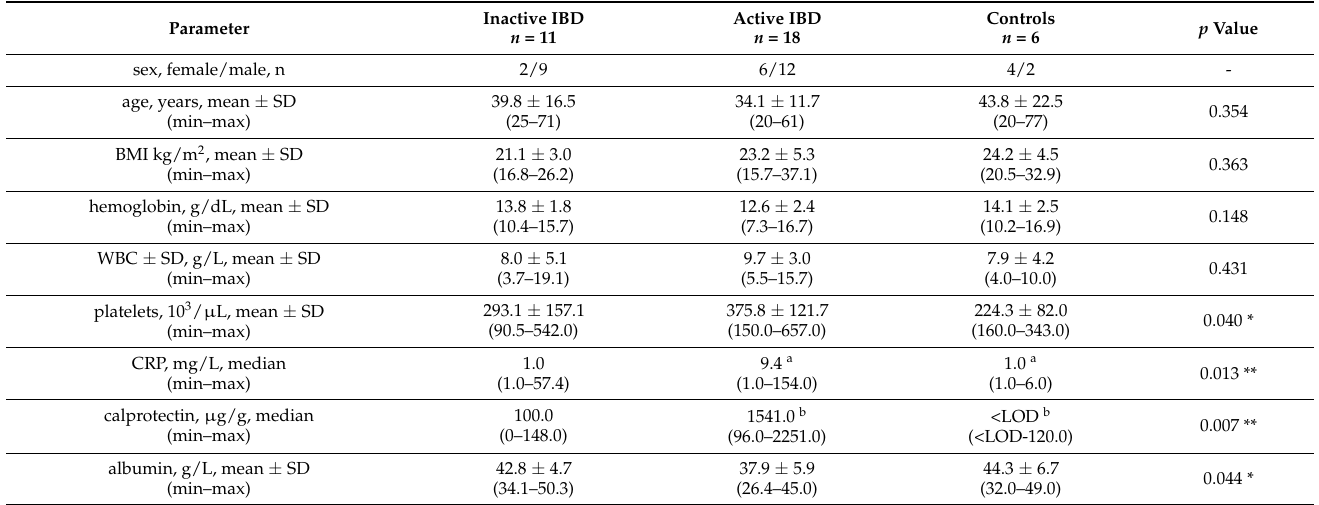
Table 1. Characteristics of participants and the results of standard tests in patients with inactive inflammatory bowel disease (IBD), active IBD, and controls.